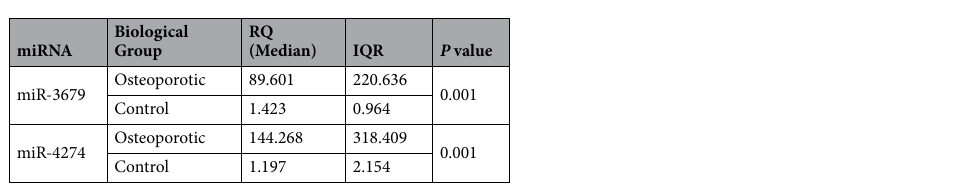
Table 3. miRNA expression levels, comparison between osteoporotic and non-osteoporotic bone samples. Abbreviations: RQ = Relative quantification; IQR = Interquartile